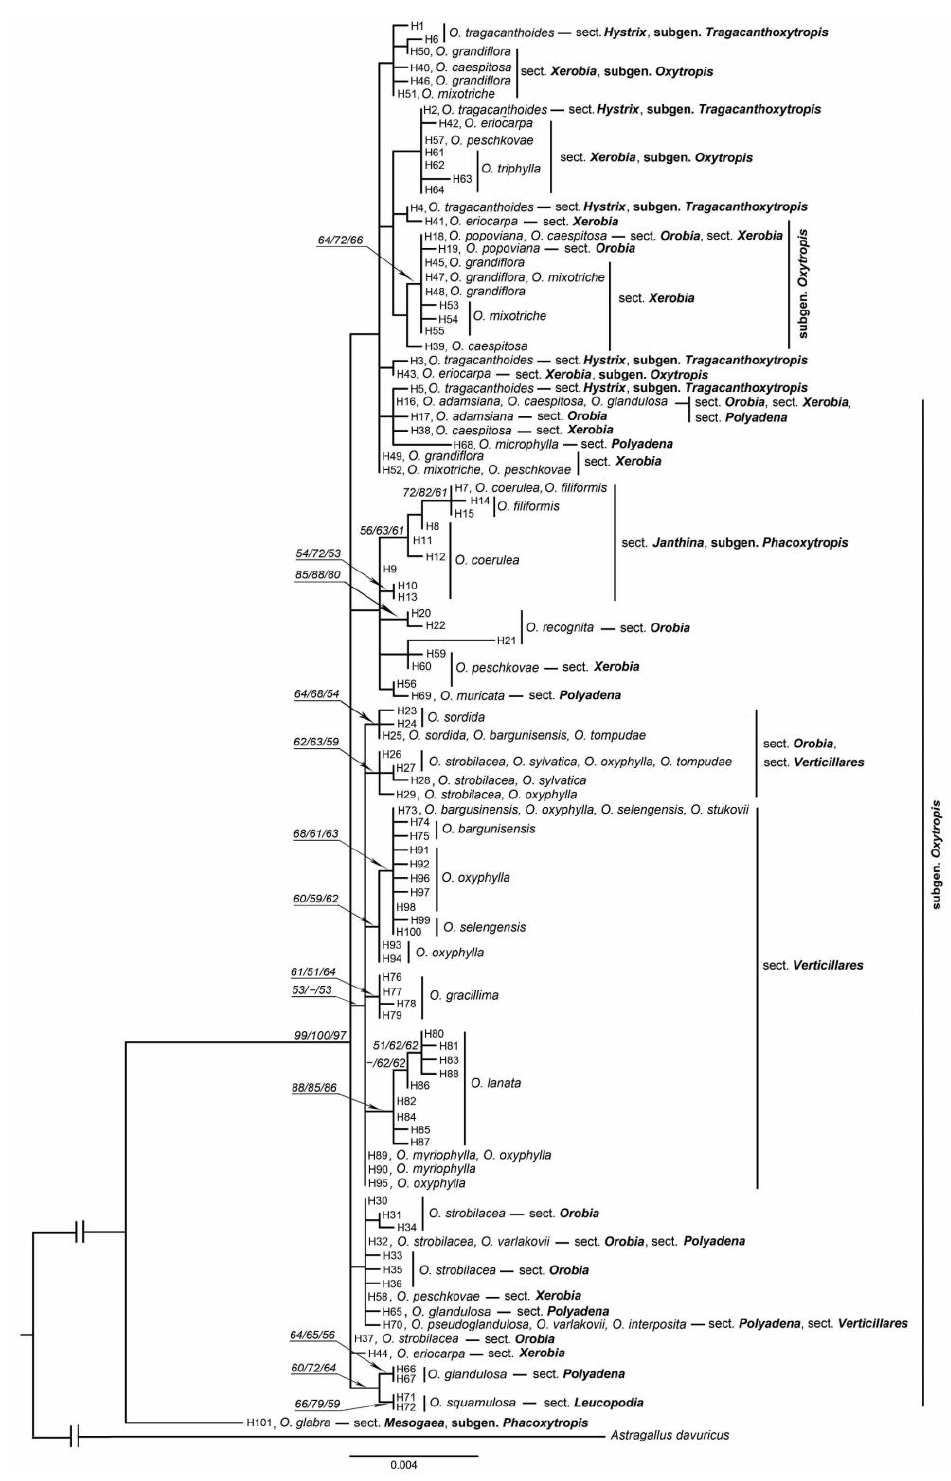
Figure 4. Maximum-likelihood topology obtained from the combined psbA-trnH , trnL-trnF , and trnS-trnG dataset and generated by PAUP under the GTR + I + G model showing branch lengths ( – ln likelihood = 4997.50) for 69 populations of 31 Oxytropis species from Southern Siberia and Astragalus davuricus (accession numbers in GenBank LM653198, LM653161, and LM653235) as outgroup species. The numbers at nodes indicate bootstrap values (BI > 50%) for MP/NJ/ML analyses, respectively. The scale bar denotes the number of substitutions per site.